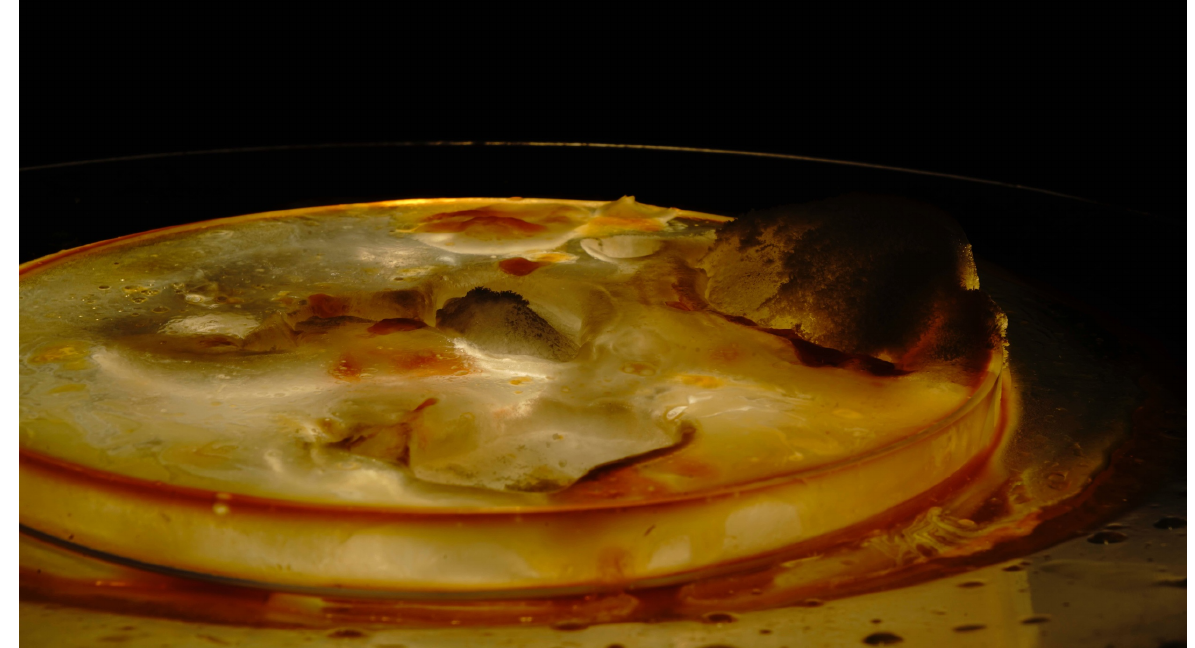
Figure 7: Detail of oil sublimating frozen carbon dioxide, Crude Illumination . Photo: Elia